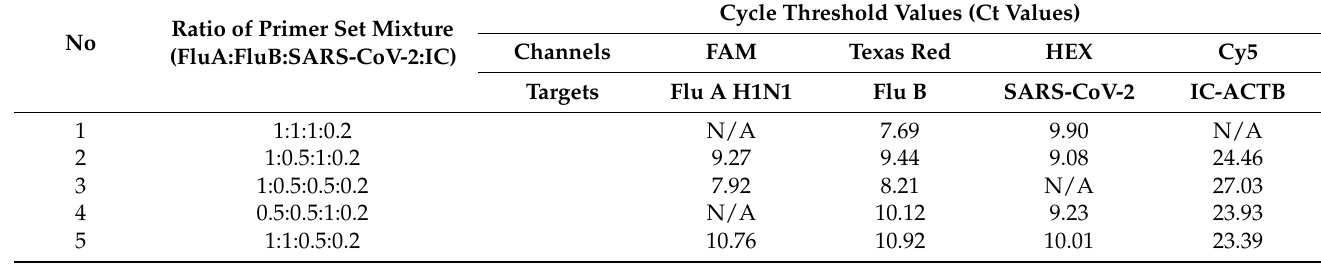
Table 2. The sensitivity of the FluA/FluB/SARS-CoV-2 multiplex LAMP assay according to different concentration ratios of the influenza A, influenza B, SARS-CoV-2, and internal control LAMP primer